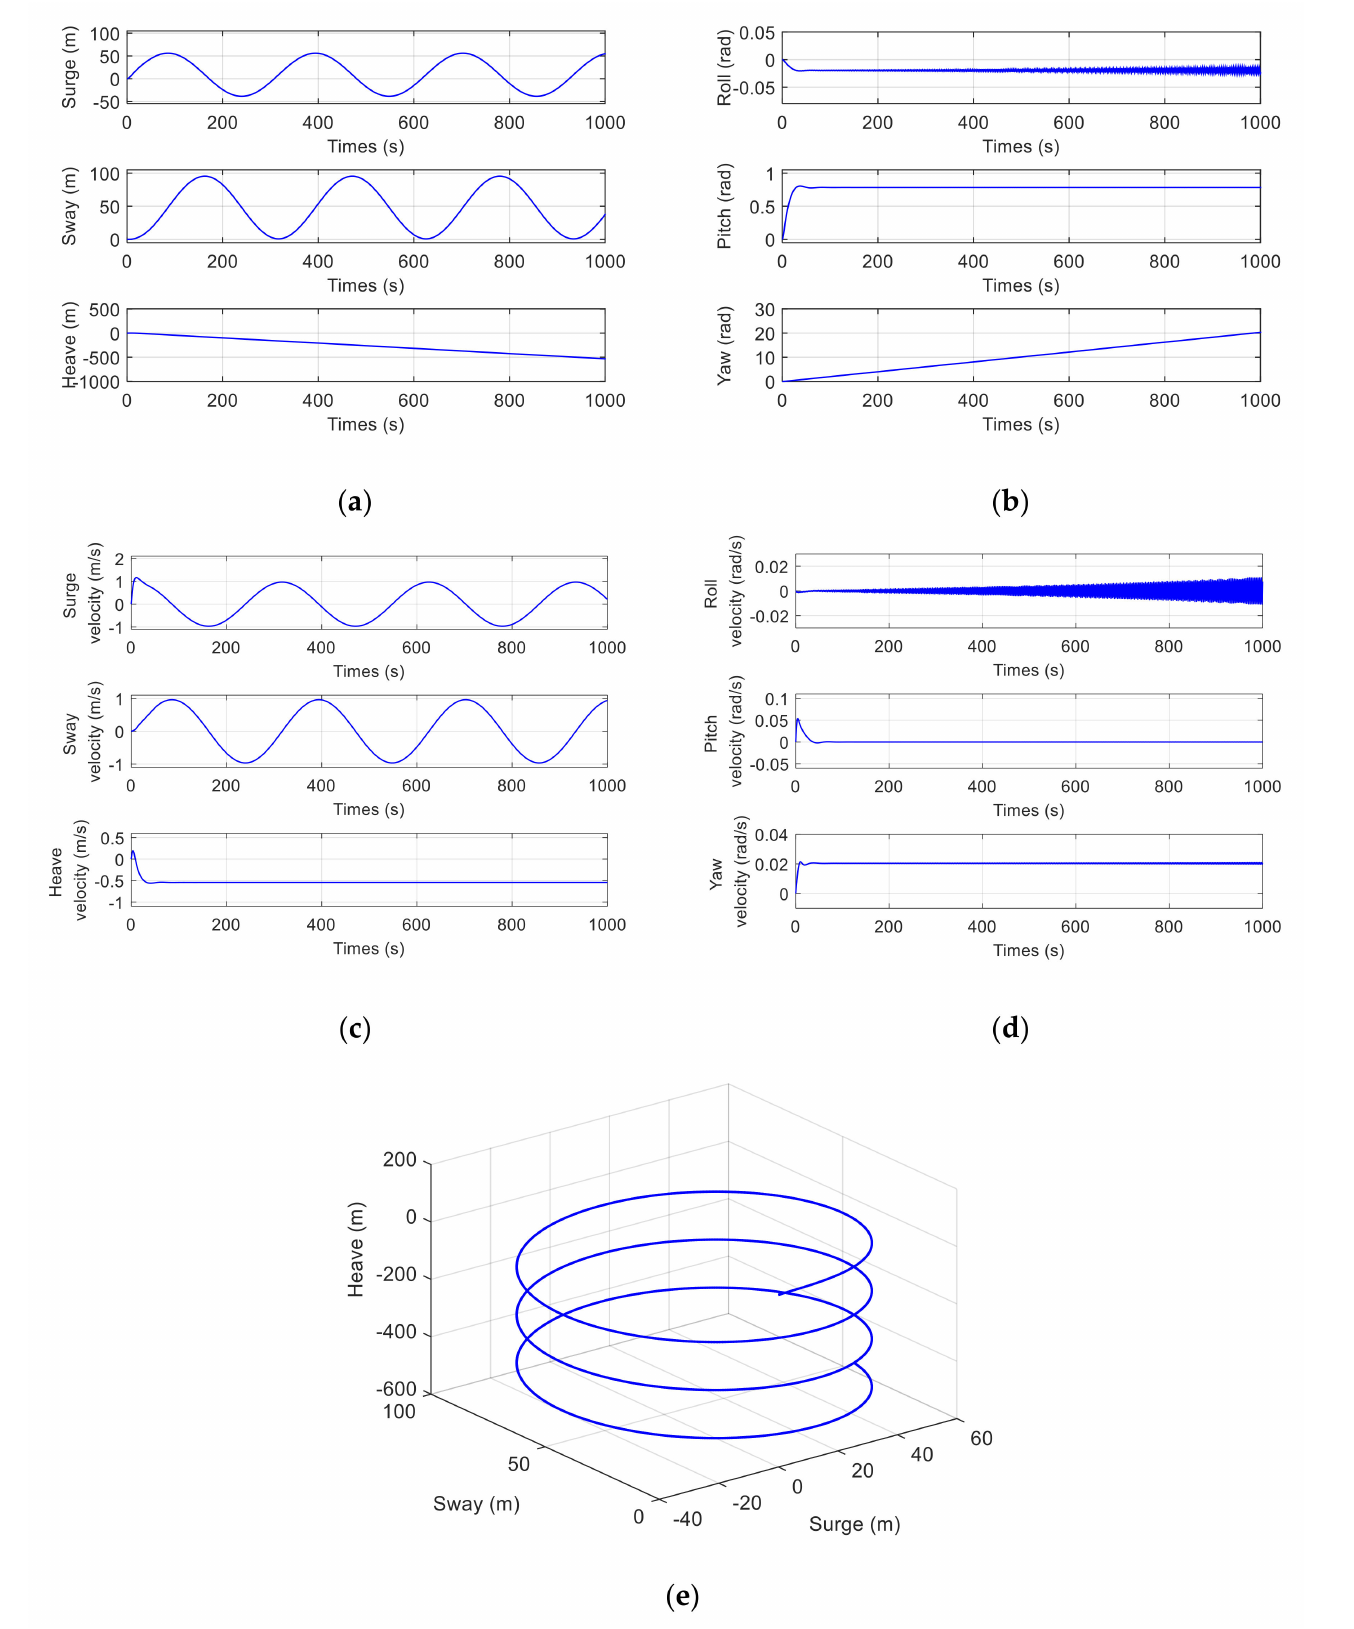
Figure 7. Spiral dive motion of the MJ-AUV: ( a ) Position changes over time; ( b ) Attitude changes over time; ( c ) Linear velocity changes over time; ( d ) Angular velocity changes over time; ( e ) 3D